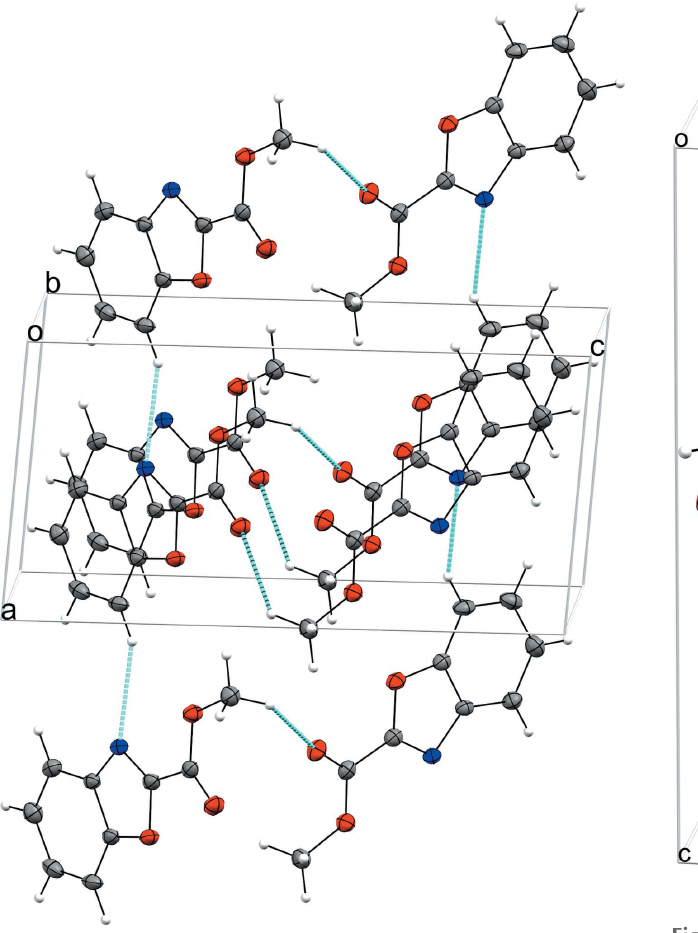
Figure 2 C—H (cid:2)(cid:2)(cid:2) N and C—H (cid:2)(cid:2)(cid:2) O hydrogen bonds (blue dotted lines).